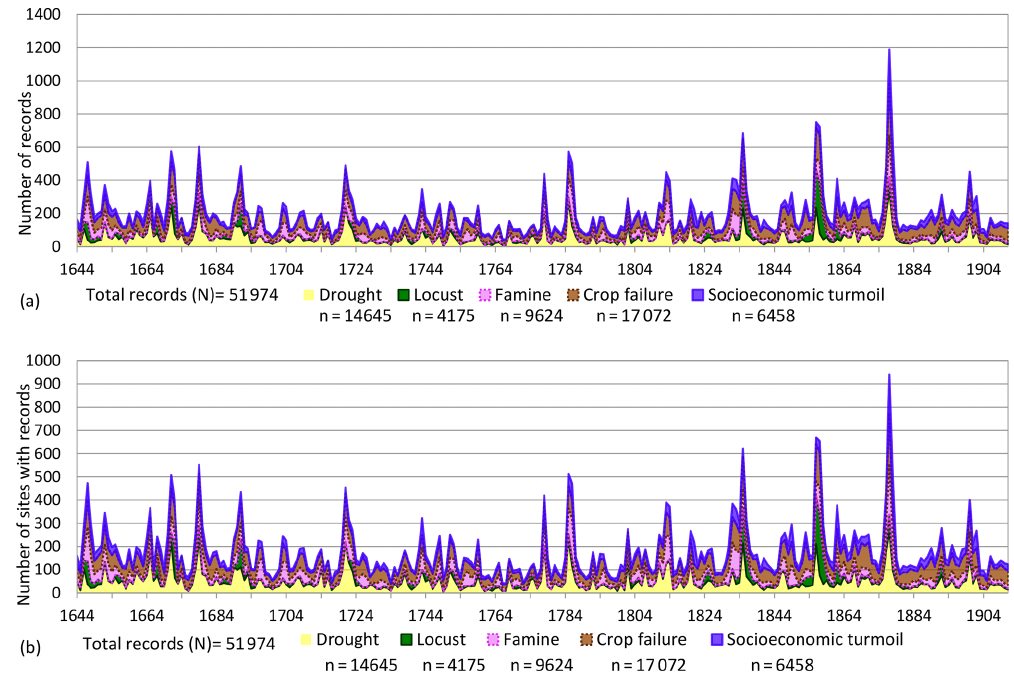
Figure 1. Time series plots of drought and associated series derived from the REACHES database. Panel (a) shows the number of records per year and panel (b) shows the number of sites (counties, cities, or prefectures) that have records for the year. Thus, one site may have more than one record for the year. Note that the drought variable here includes meteorological and dried-water-body-related hydrological drought, crop failure is interpreted as agricultural drought, and famine and socioeconomic turmoil are taken to represent socioeconomic